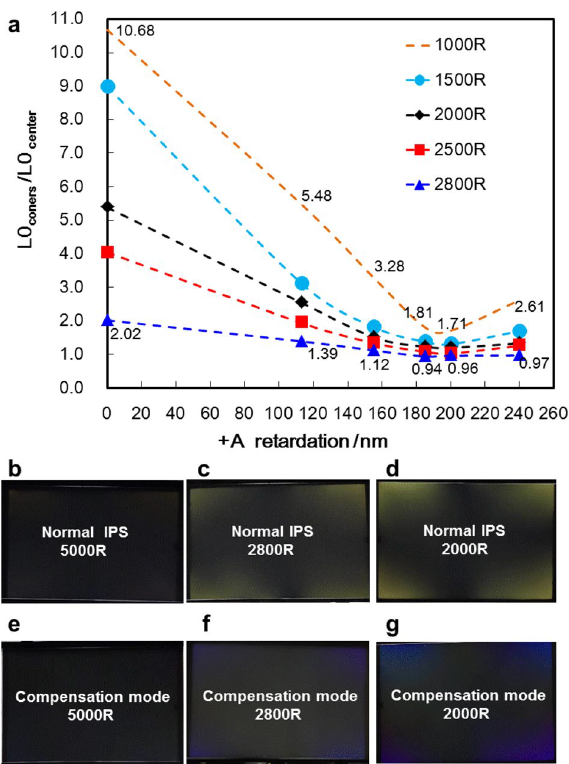
Figure 11. ( a ) The L0 brightness of the curved panels. ( b – d ) The photos of curved normal IPS. ( e – g ) The photos of curved compensation mode